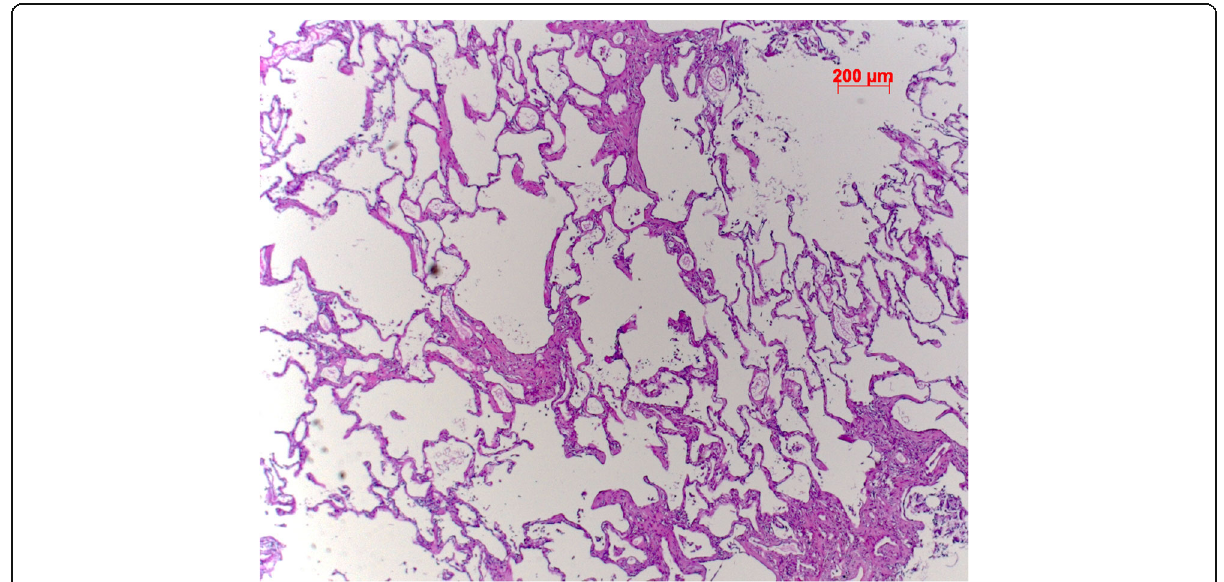
Fig. 2 In this case of UIP there are areas of fibrosis, few myofibroblastic foci, and normal lung. H&E, bar 200 μ